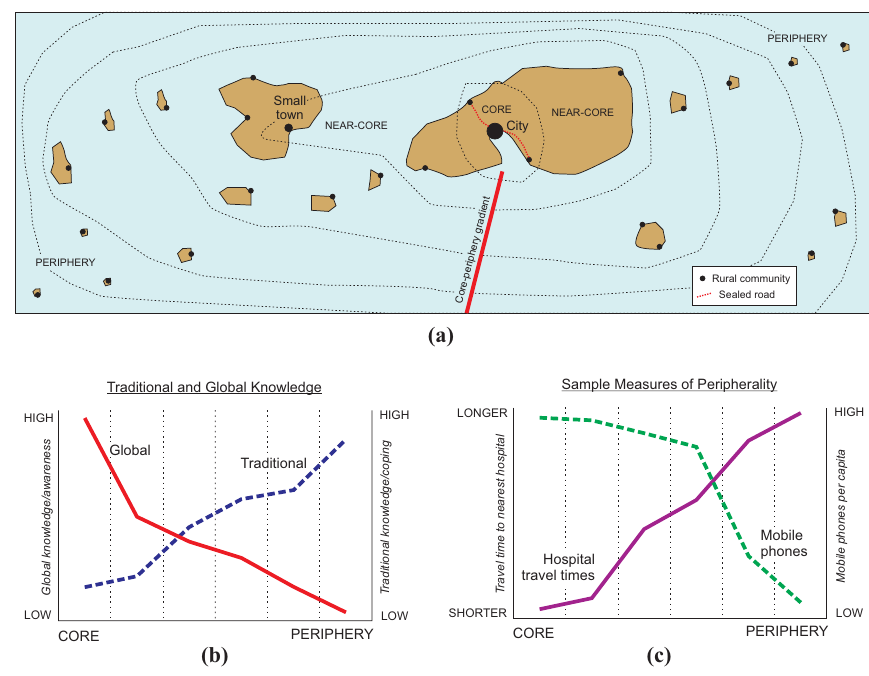
Figure 4. The concept and measurement of peripherality in an (invented) archipelagic